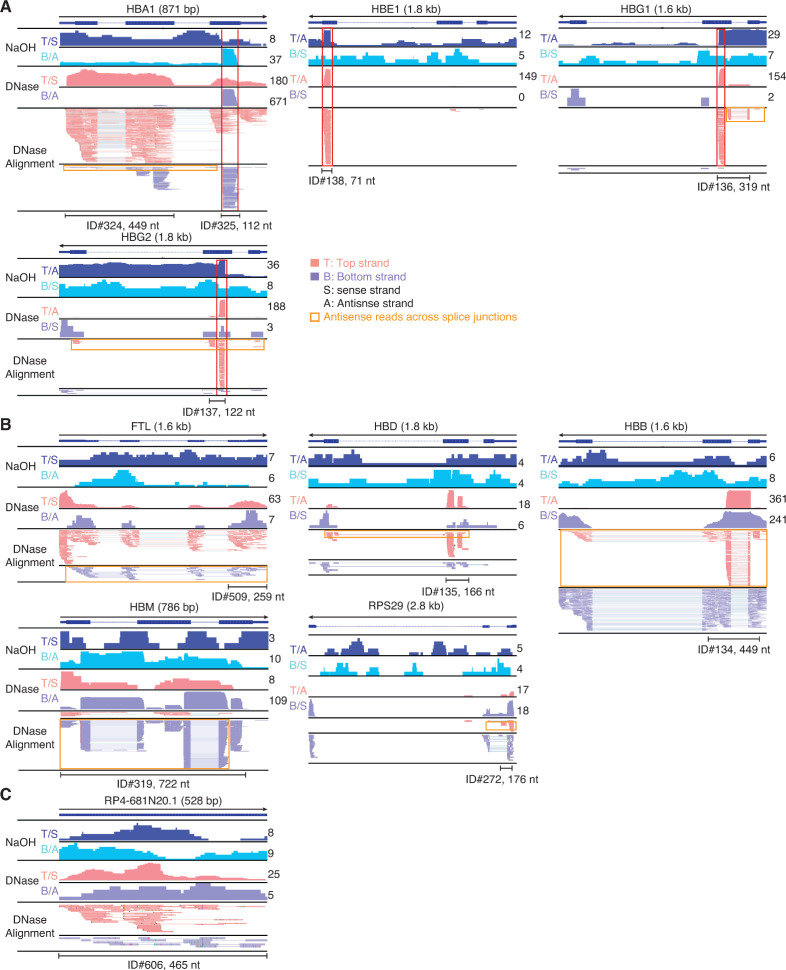
IGV screenshots of other peaks mapping to the antisense strand of annotated genes or pseudogenes.Gene names are indicated at the top with the length of the gene indicated in parentheses and an arrow below indicating the 5’ to 3’ orientation of the mRNA or annotated pseudogene transcript. IGV screenshots are labeled as in Figure 9, but with separate coverage plots shown for the top (T) and bottom (B) strands for the NaOH-treated plasma DNA samples, and the top and bottom strands indicated as sense (S) or antisense (A) depending on the orientation of the mRNA or annotated pseudogene transcript. The RNA peak is delineated by a bracketed black line, with the peak ID number and length indicated below. Reads shown in the alignment tracks were down sampled to a maximum of 100. (A) Antisense peaks (other than the three shown in Figure 13F–H) that map to genes that are highly represented in plasma and contain regions mirrored by DNA peaks in NaOH-treated plasma DNA sample red boxes extending vertically across the alignments and coverage plots. (B) Other antisense peaks that map to mRNAs that are highly represented in plasma. (C) An antisense peak that maps to a pseudogene. Horizontal orange boxes delineate antisense reads that extend across multiple spliced exons.